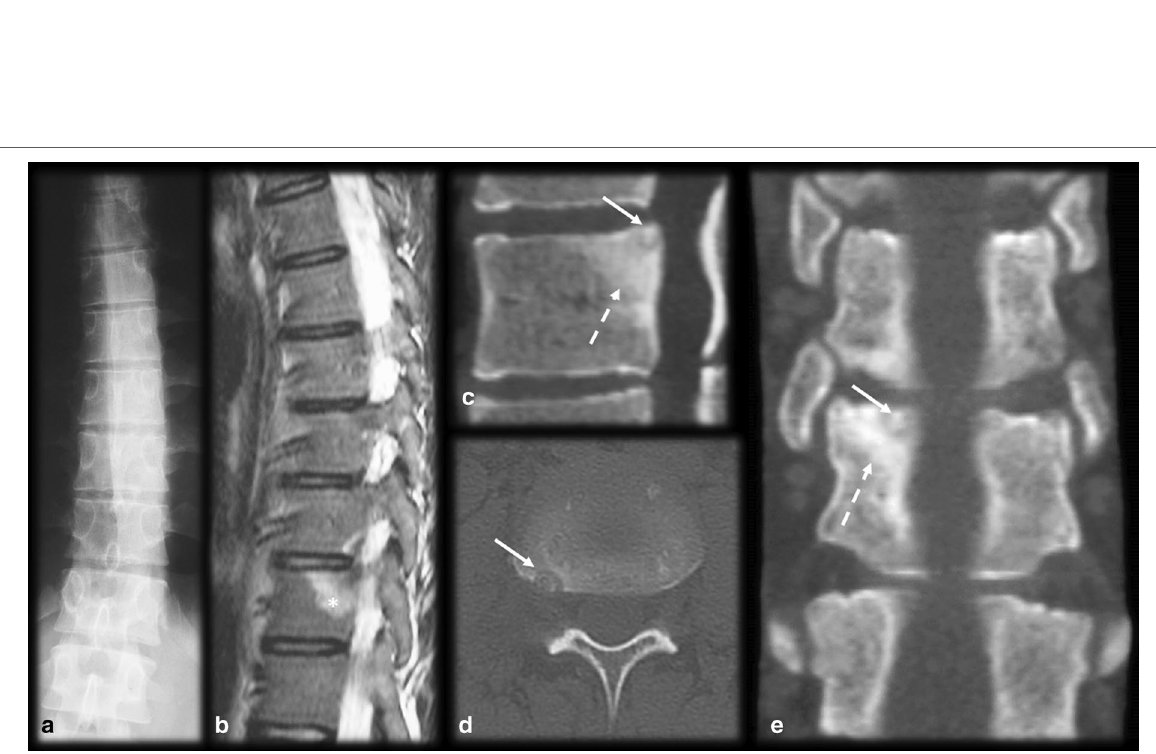
Fig. 18 Osteoid osteoma mimicking enthesitis. Male, 20 years old, presenting with back pain for six weeks. CR ( a ) showed left scoliosis with no identifiable bone lesions. Sagittal T2 FS MRI ( b ) revealed bone marrow edema on the posterosuperior corner of the vertebral body (asterisk), which raised the suspicion for enthesitis. The CT scan ( c , d , e ) showed a small and mineralized nidus on the concave side of the region of scoliosis (arrow) with reactional bone sclerosis (dashed